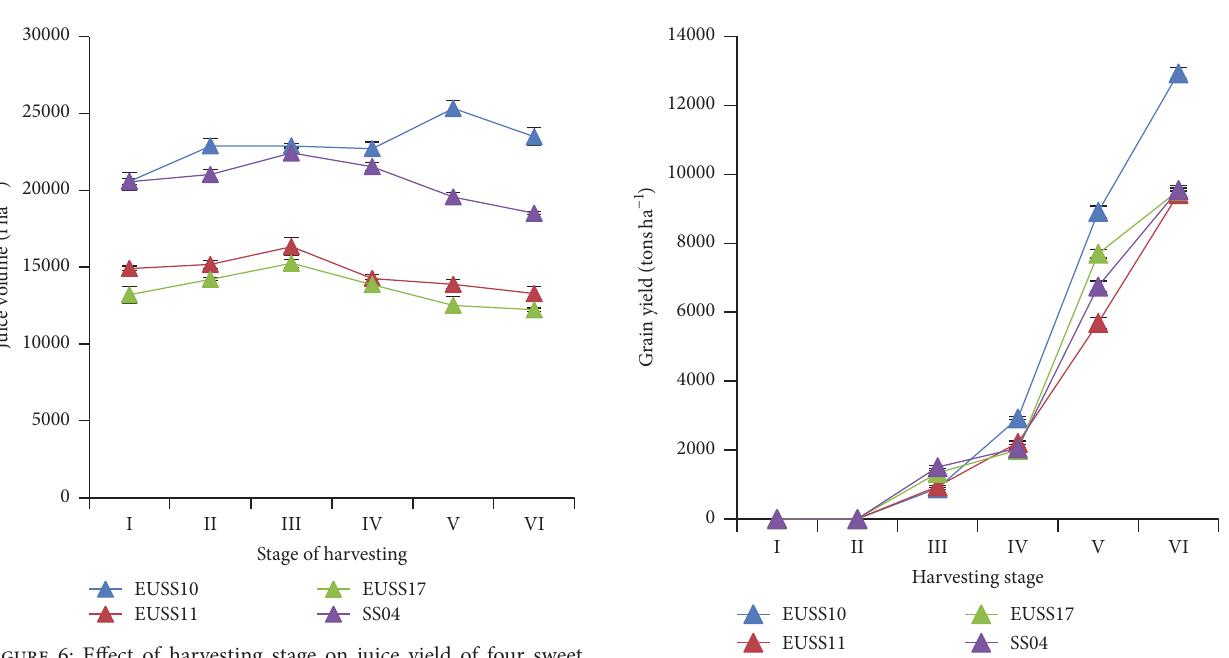
Figure 8: Effect of harvesting stage on grain yield among four sweet sorghum genotypes in western